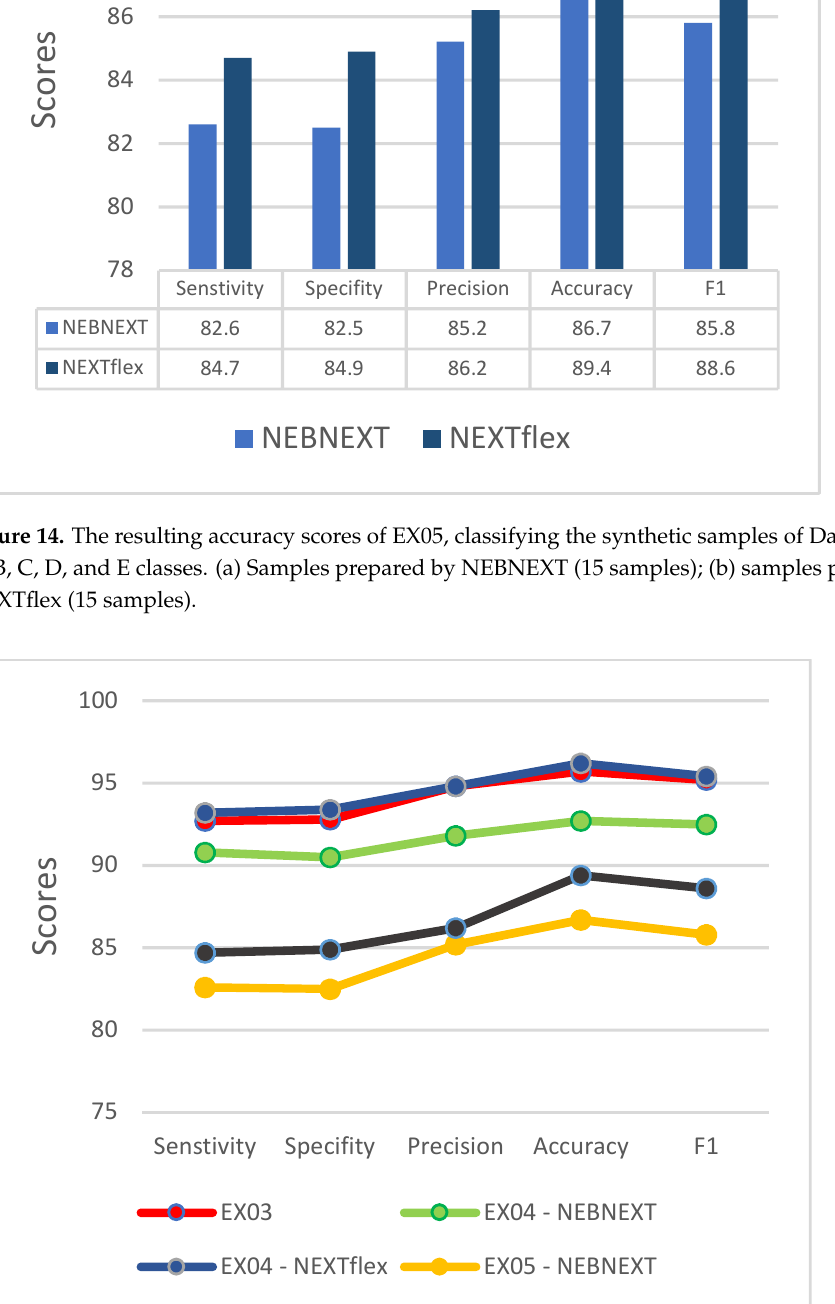
Figure 15. Consolidated results of all experiments conducted on Model_I over Dataset_I (EX03, EX04, and EX05).